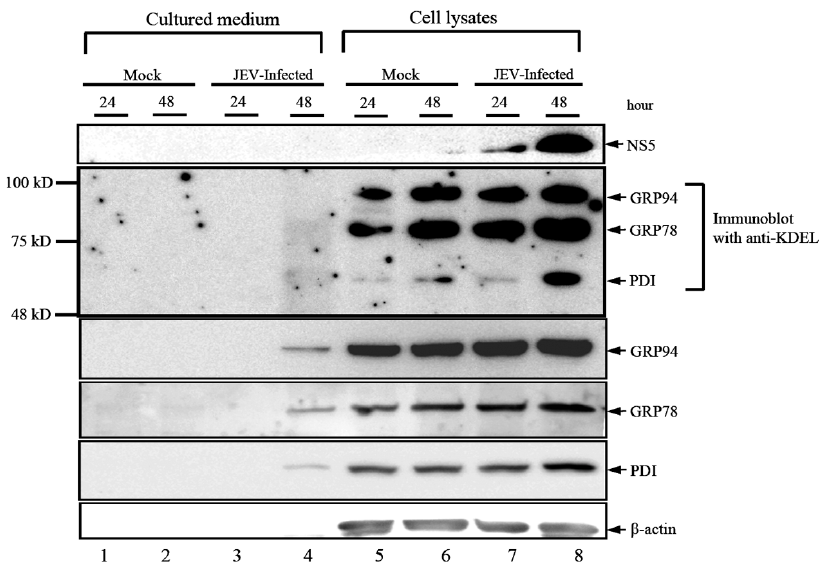
Figure 1. Detection of extracellular ER lumen proteins in the secreted medium from JEV-infected BHK-21 cells. BHK-21 cells were mock-infected or infected with Japanese encephalitis virus (JEV) at